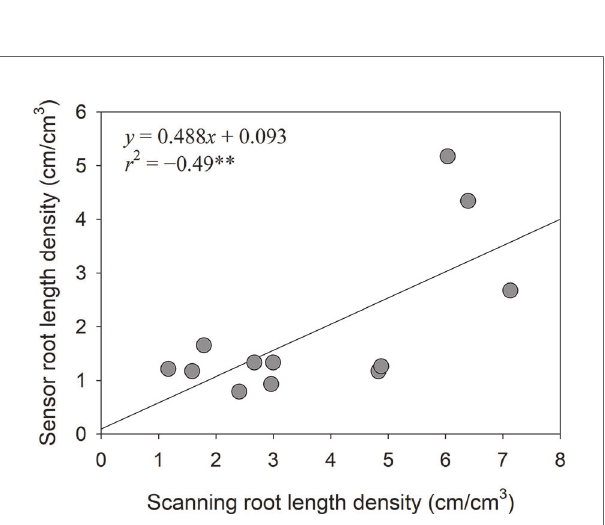
FIGURE 8 | Linear regression of scanning method vs Rootsnap sensor method.